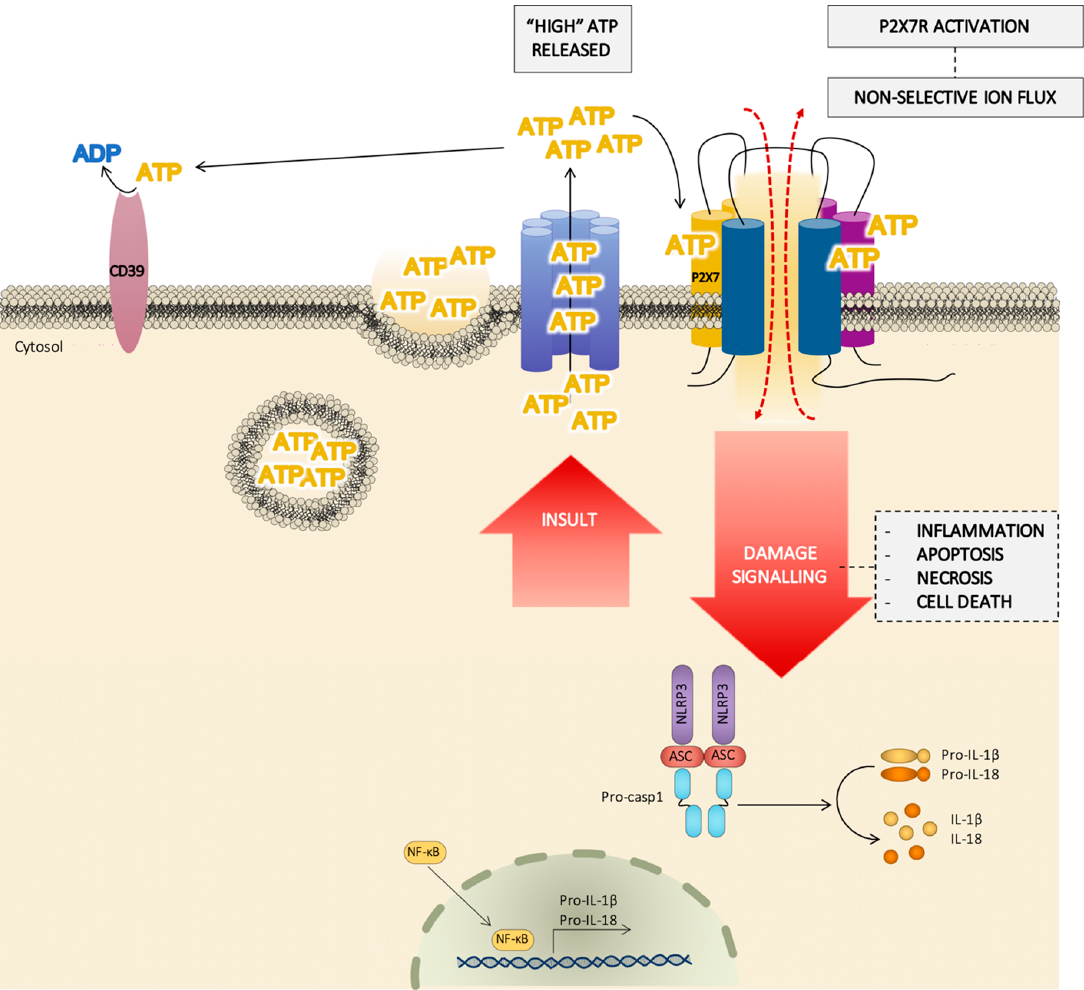
Figure 4. Schematic pathway of the role of the P2X7 receptor (P2X7R) in cell damage signaling. In response to a severe damage or an insult signal, the cell releases a huge amount of adenosine triphosphate (ATP) by different mechanisms (from ATP dense granules, ATP channels, …) and the extracellular concentration of ATP reached could be enough to activate the P2X7R, facilitating a flux of large ions and the activation of the inflammasome. The P2X7R/inflammasome complex induces the synthesis of IL-1 β and IL-18, also regulated by NF- κ B. This hypothesis agrees with the role of the P2X7R in processes such as inflammation, apoptosis, and necrosis.